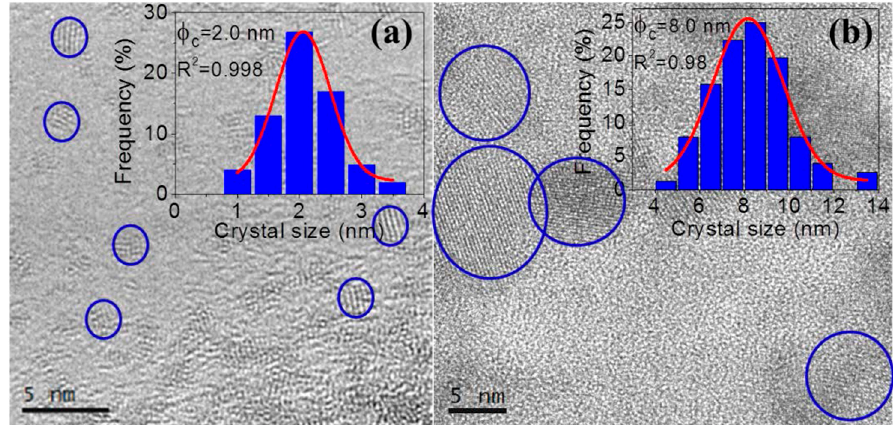
Figure 10. HRTEM of 80SiO 2 -20LaF 3 ( a ) thin film and ( b ) self-supported layer prepared using TEOS/MTES and treated at 550 °C for 1 min. The corresponding crystal size distributions are also shown.